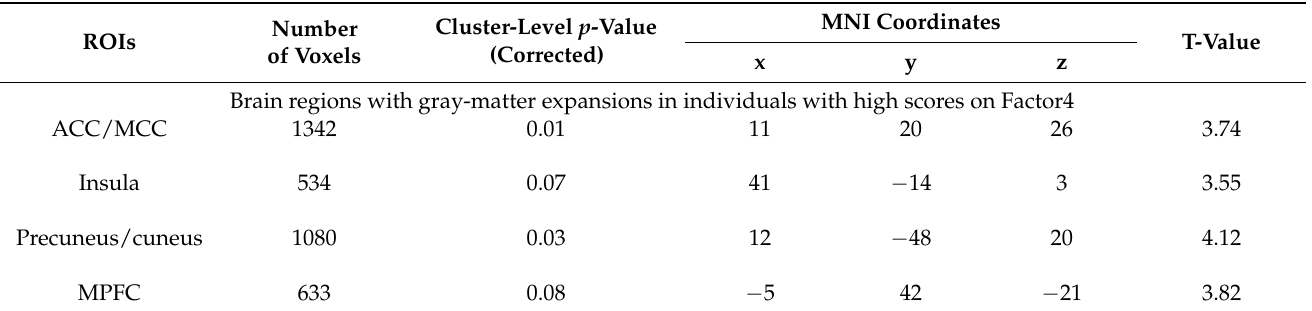
Table 3. Results of ROI